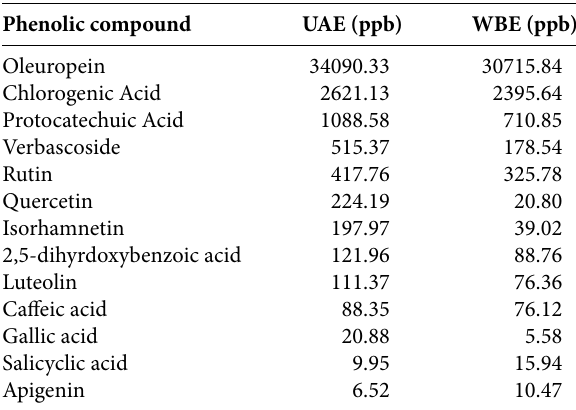
Table 2. Content of individual phenolics of olive leaf extracts by LC- MS/MS Phenolic compound UAE (ppb)